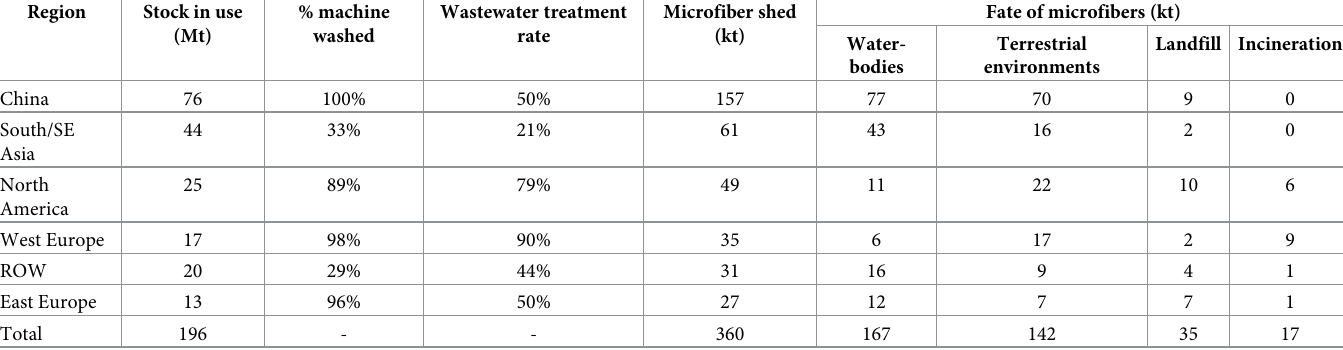
Table 1. 2016 Regional apparel in use stock in million metric tonnes (Mt), percentage of clothing machine washed, wastewater treatment rate, microfibers shed, and fates of microfibers, both in thousands of tonnes (kt). The four fates of microfibers are: waterbodies, terrestrial environments, landfill, and incineration. ROW stands for rest of